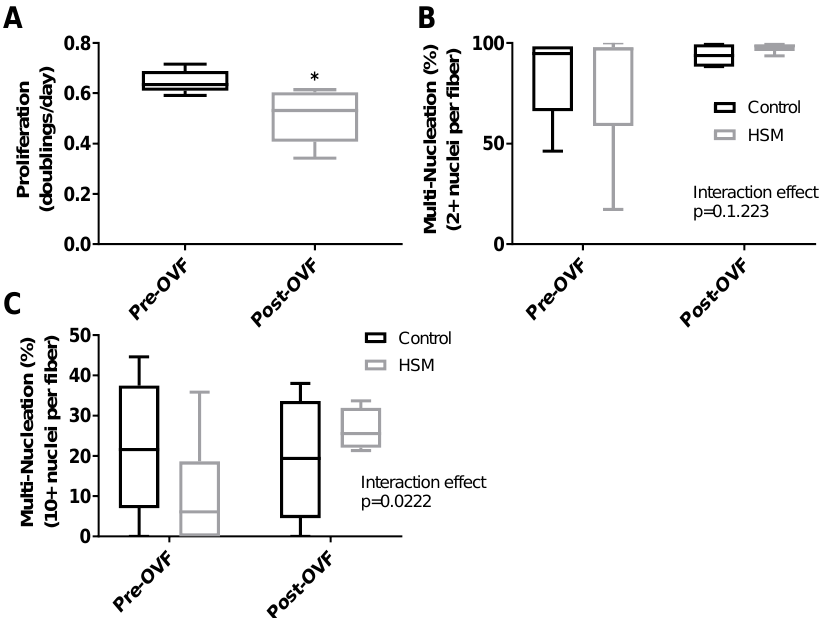
Figure 4. Proliferation rates (doubling/day) of satellite cells (SCs) isolated from human participants ( n = 4) pre and post one week of overfeeding (OVF, 55% fat + 100 kcal) ( A ). Fusion index scores after eight days of differentiation (( B ), 2+ nuclei per fiber, ( C ), 10+ nuclei per fiber) of SC from donors collected pre-OVF and post-OVF in control or high subsrate media (HSM) (+400 mM, 2:1, oleate – palmitate, +20 mM glucose). (*, **, *** indicating a p -value of <0.05, <0.01, <0.001, respectively).